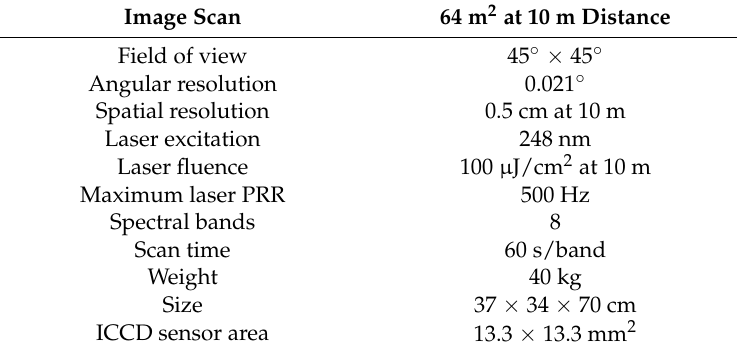
Table 2. Final system characteristics.